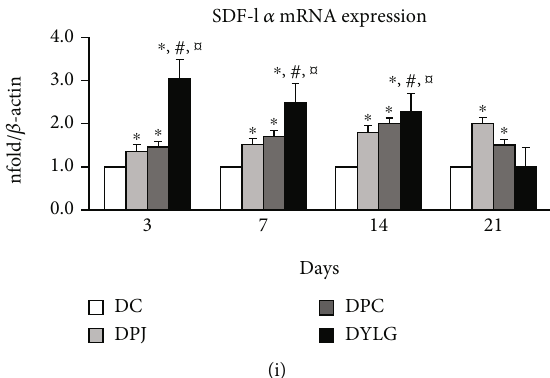
Figure 4: (a – i) Relative mRNA expressions of TNF- α , NF- κ B, MMP-9, IL-1B, VEGF, TGF- β 1, EGF, IL-10, and SDF-1 α , respectively, in diabetic rats on days 3, 7, 14, and 21 postwounding. Data were normalized by β -actin at each time